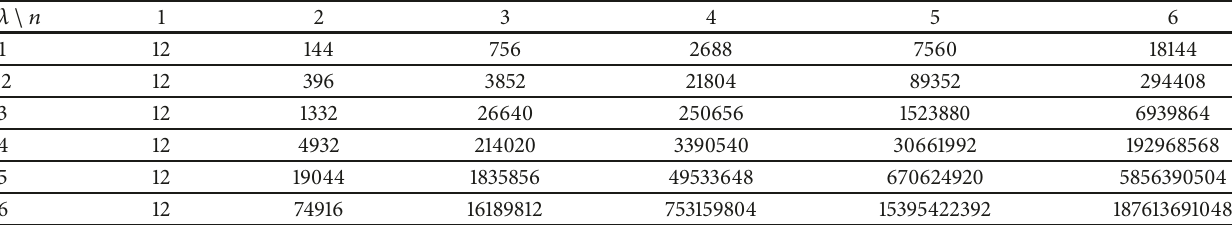
Table 8: Modified hyper Wiener index of 𝑇𝑂𝑋